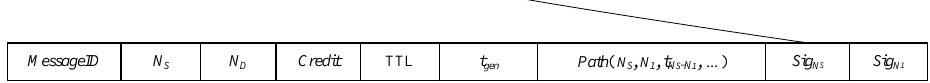
Figure 4. Forwarding ticket.